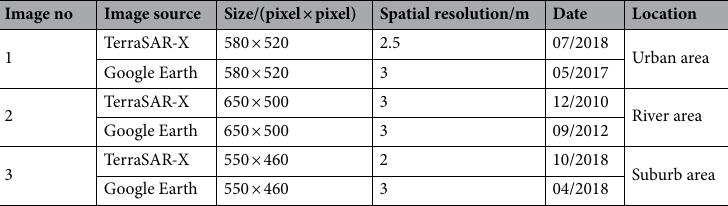
Table 1. Detailed description of dataset.